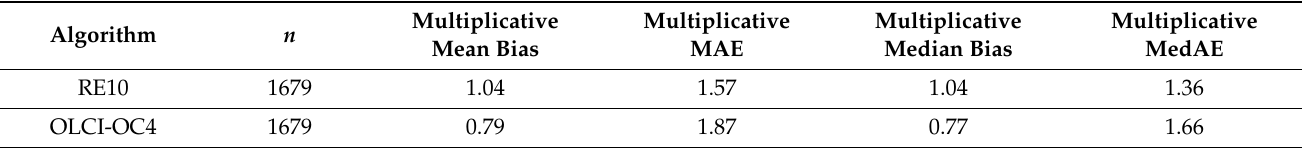
Table 1. Bulk statistics for OLCI-RE10 and OC4 for all pixel to field sample matchups ( n = 1679) which are plotted by station in Figures 4 and